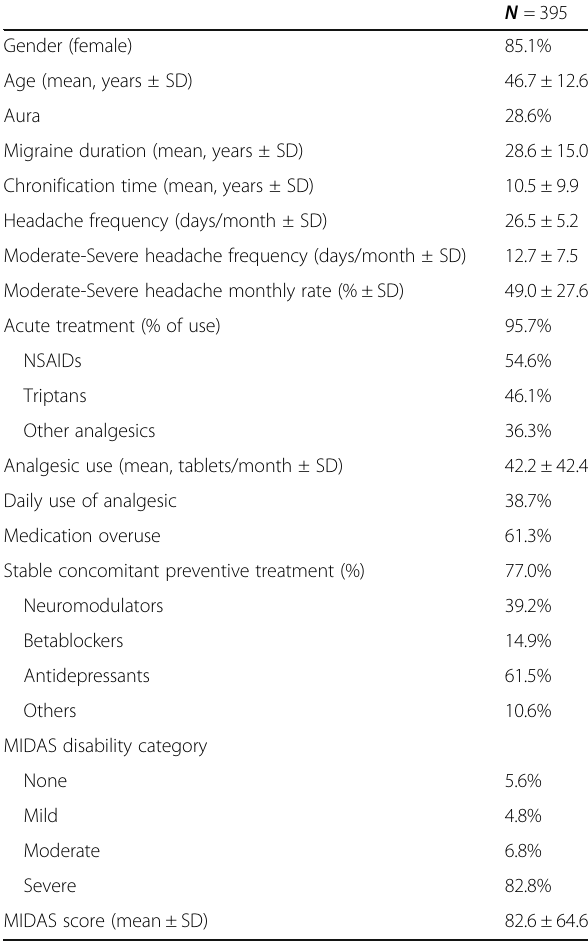
Table 1 Baseline Demographics and Migraine